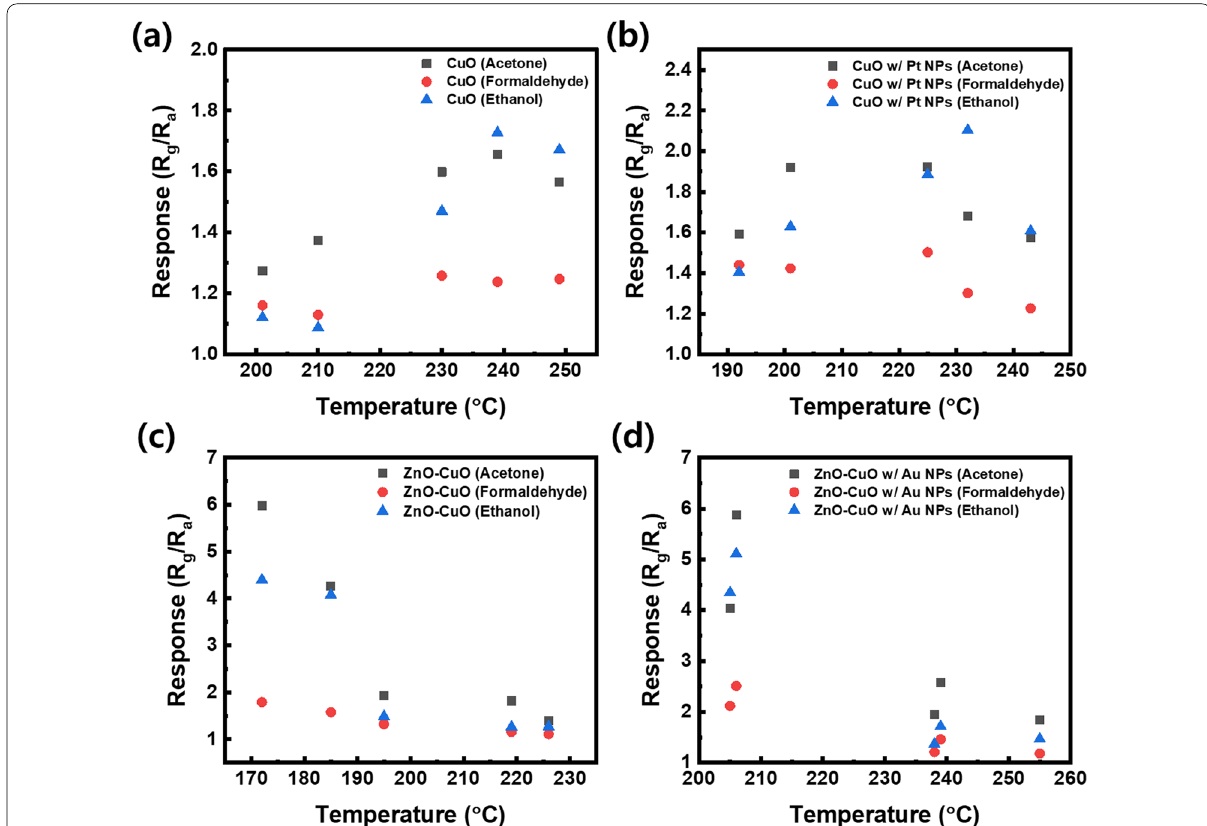
Fig. 4 Response of CuO, CuO with Pt NPs, ZnOCuO hollow nanocubes and ZnO–CuO hollow nanocubes with Au NPs to acetone, formaldehyde and ethanol 1 ppm with different temperatures